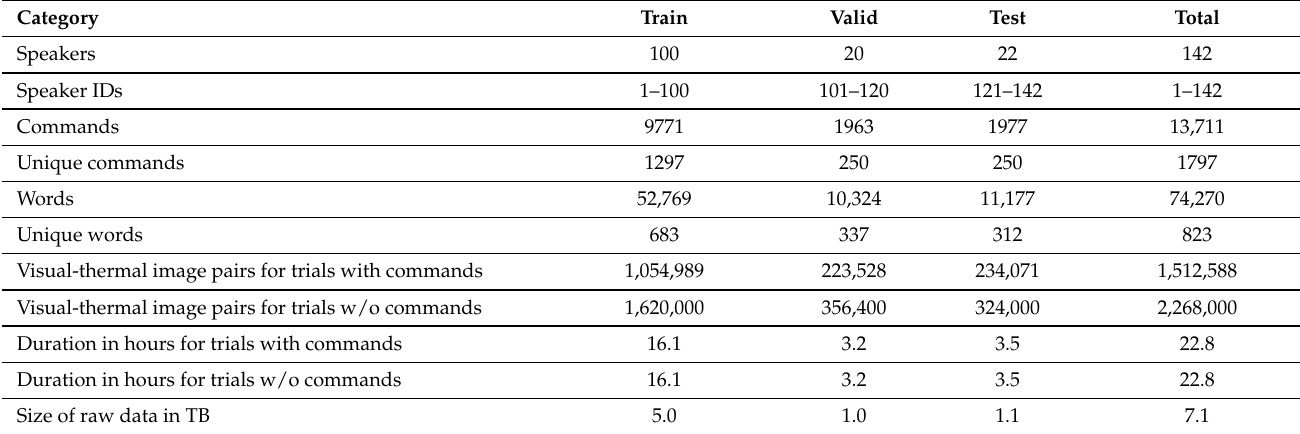
Table 2. Statistics on